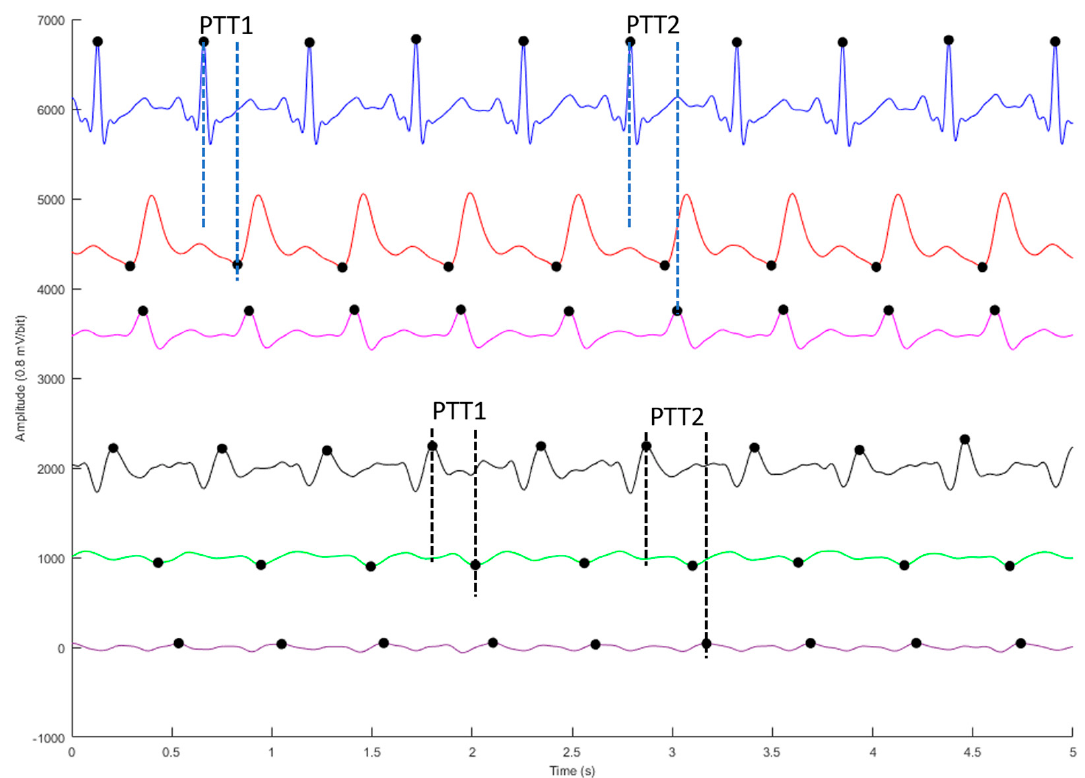
Figure 3. The four signals and their differential signals, ECG (blue), PPG (red), differential PPG (DPPG, magenta), BCG (black), IPG (green), and differential IPG (DIPG, purple). The R wave of ECG, J wave of BCG, main peak of DPPG and DIPG, and foot point of PPG and IPG are marked by black dots. These signals are offset to visually separate them.